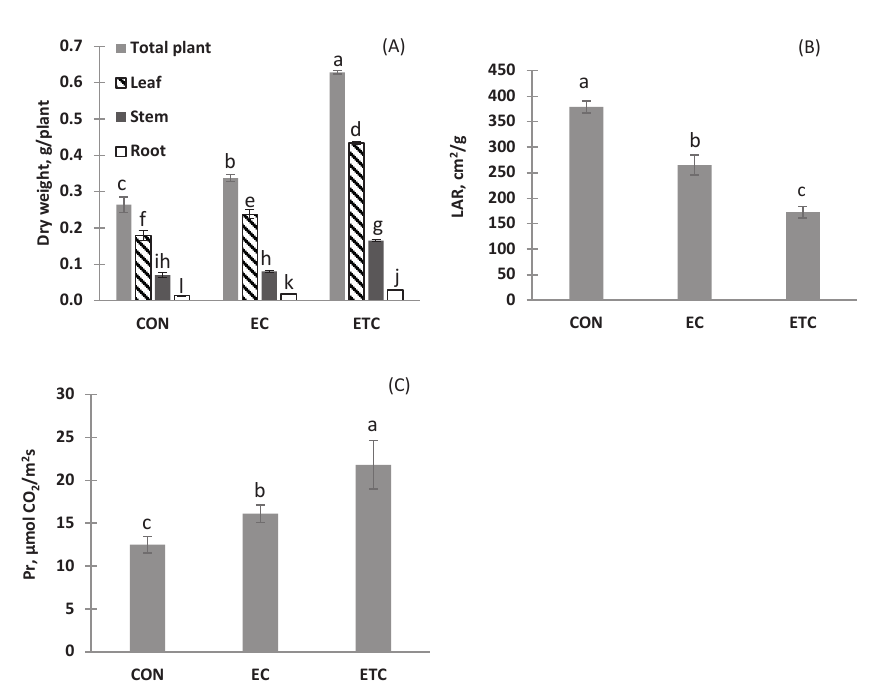
Fig. 1. Photosynthesis parameters and morphological parameters: A. Total plant dry weight and weight of different parts of plant; B. Leaf area ratio (LAR); C. Photosynthetic rate (Pr). Different letters indicate significant differences among treatments ( p <0.05) based on